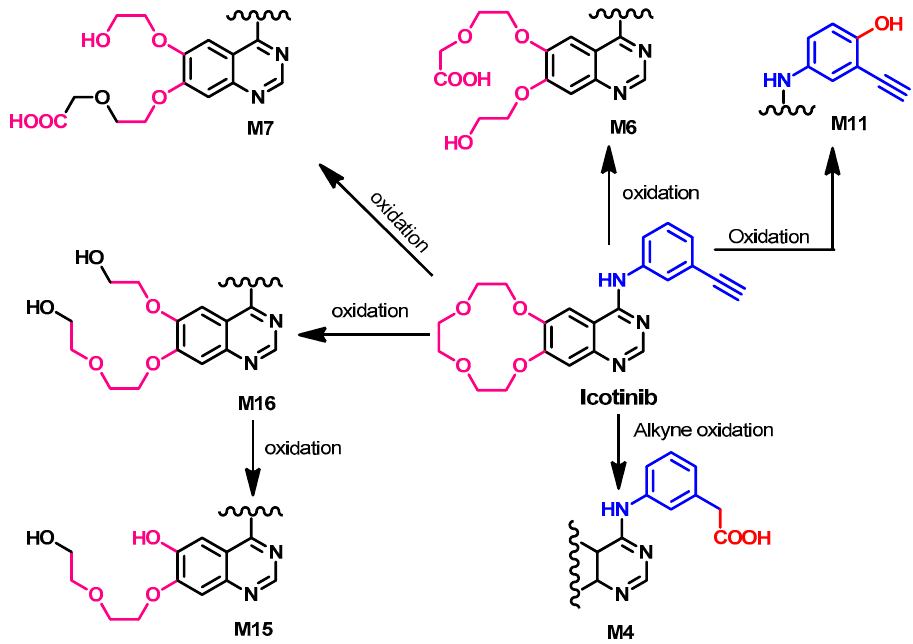
Figure 38. Proposed metabolic pathways of icotinib by human liver microsomes.